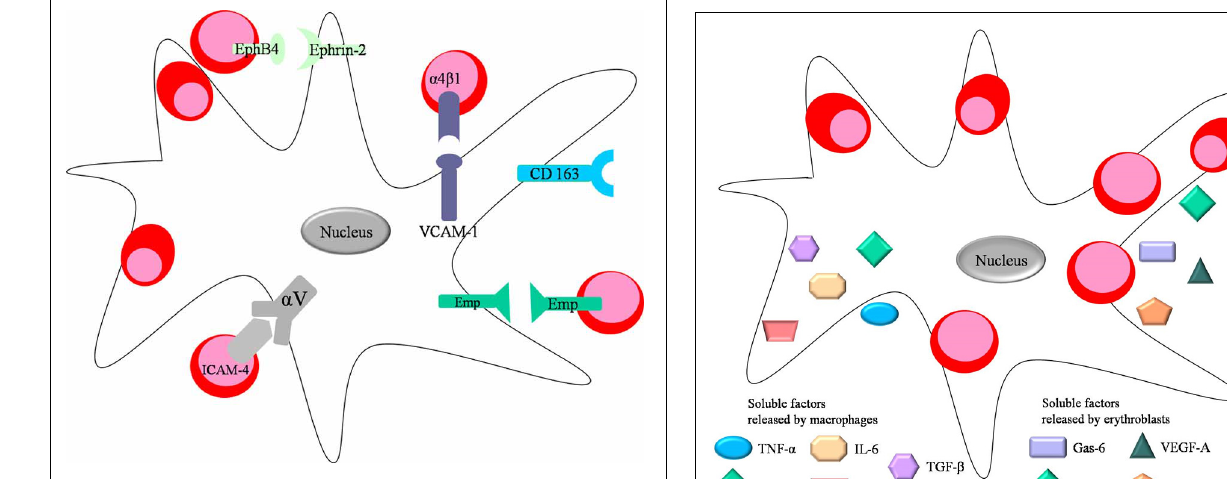
FIGURE 2 | Direct interactions between the central macrophage and developing erythroblasts. Macrophages express VCAM-1 and integrin α V on their surface facilitating interaction with erythroblasts through integrin α 4 β 1 and ICAM-4, respectively. Moreover, both erythroid cells and macrophages express Emp on their surface promoting their interactions in the niche. Central macrophage and erythroblast can also interact via the ligand-receptor pair EphB4 (expressed on the surface of erythroblasts) and Ephrin-2, found on macrophages.